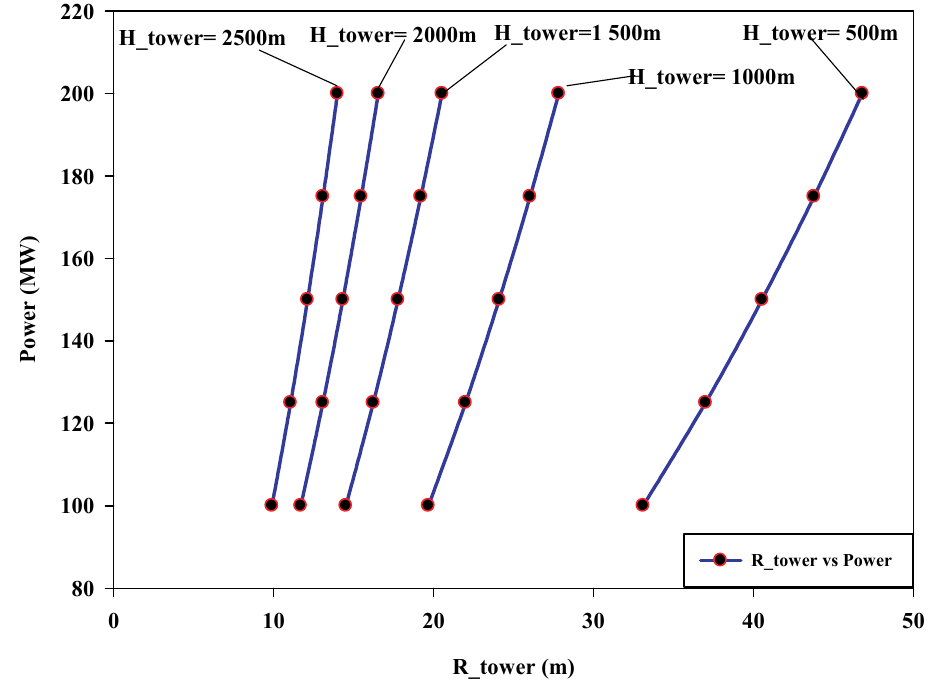
Figure 16. Effect of variation in power output on tower radius ( R Tower ) for different tower heights ( H Tower ) in SUTPP.